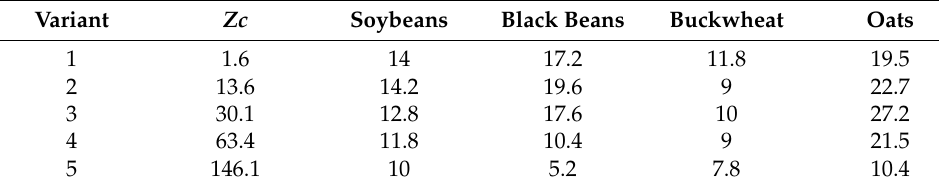
Table 9. The biological absorption coefficients of zinc for all crops and the total pollution index.